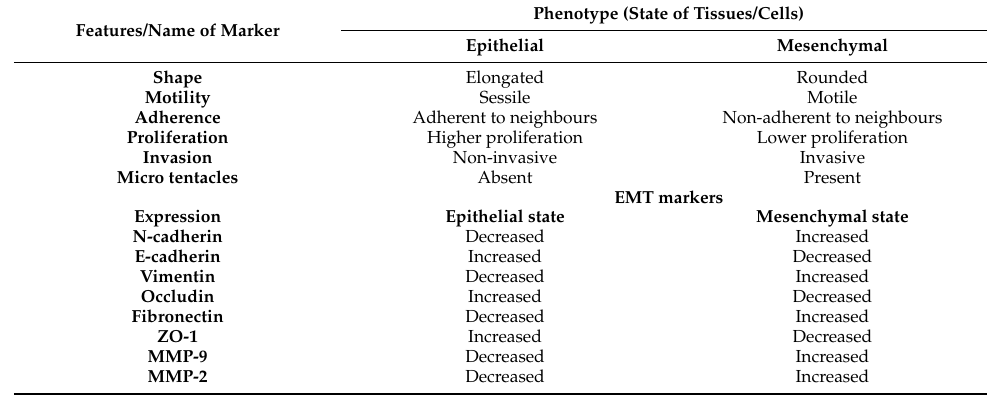
Table 2. Characteristics and Expression of different EMT markers in breast